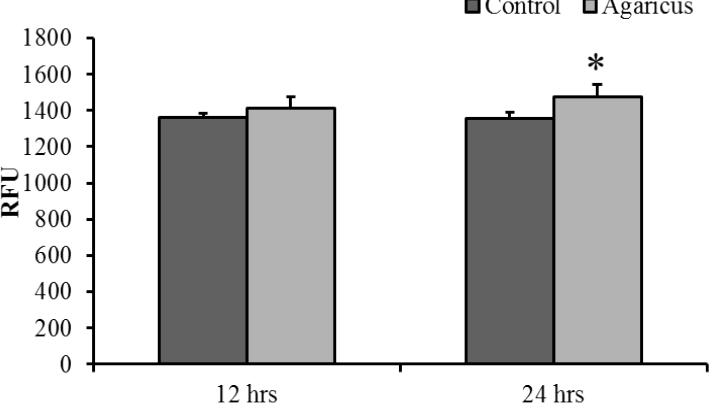
Figure 3. Phagocytic activity in stimulated macrophages. The THK cell line was treated with 0 (control) or 10 μg/mL of Agaricus blazei spent substrate extract (ABSSE) in L-15 for 12 and 24 h prior to the addition of a bioparticle solution. The relative fluorescence units (RFU) were measured and values are shown as means + standard errors of the mean. A significant difference between experimental and the control group ( p < 0.05, paired-sample t test) is indicated by an asterisk.